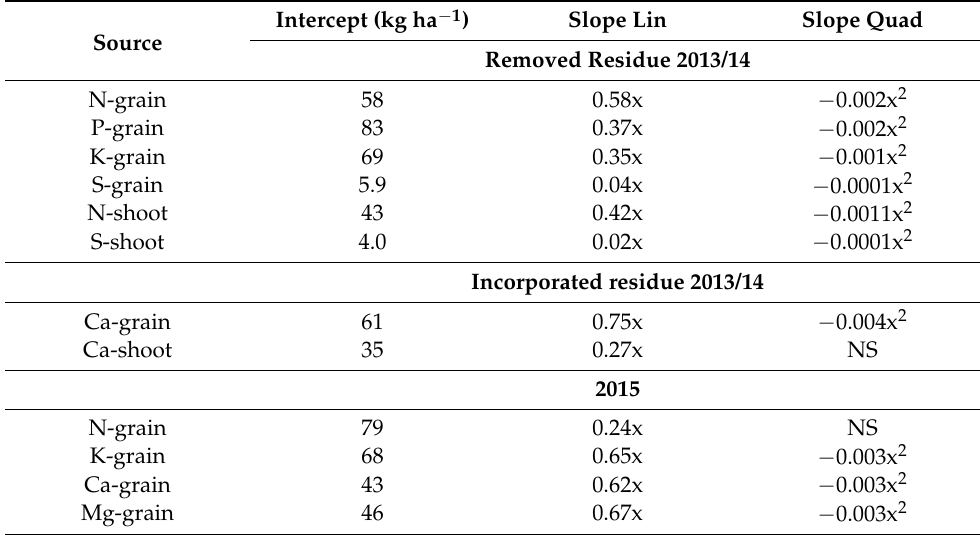
Table 1. Grain N, P, K, Ca, Mg, and S accumulation and biomass N, Ca, S accumulation in 2013, 2014, and 2015 as a function of N application